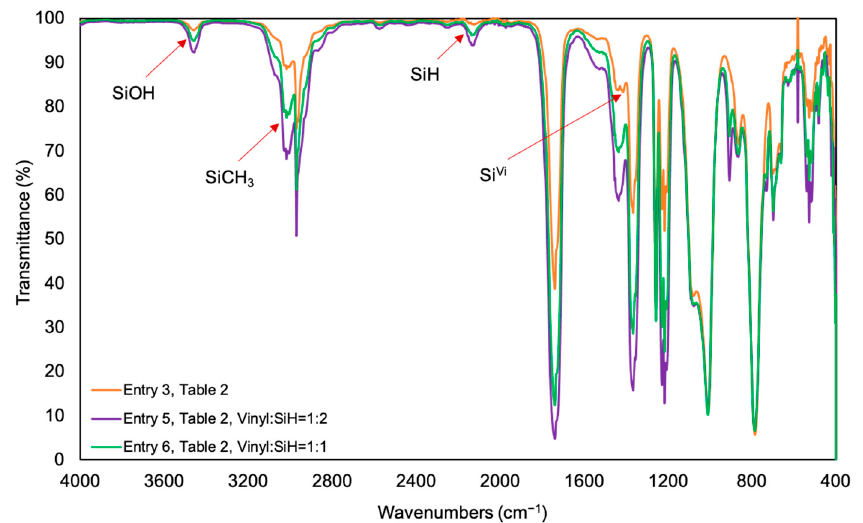
Figure 5. IR spectra for PMS-H03 modified elastomers using P-Vi-28 self-crosslinked elastomers (Table 2). The orange curve shows the IR spectra of precursor elastomer (Entry 3, Table 2), the purple curve shows the IR spectra of PMS-H03 (Vinyl:SiH = 1:2) modified elastomer (Entry 5, Table 2) and the green curve shows the IR spectra of PMS-H03 (Vinyl:SiH = 1:1) modified elastomer (Entry 6, Table 2).